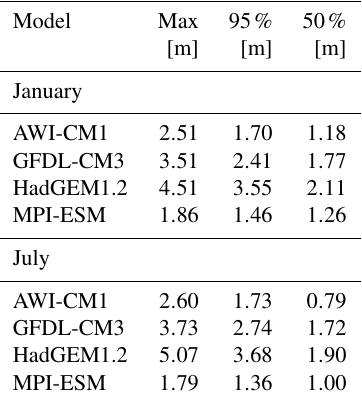
Table B1. Maximum and selected percentiles for sea ice thickness on the common subset of initial positions, derived from the control